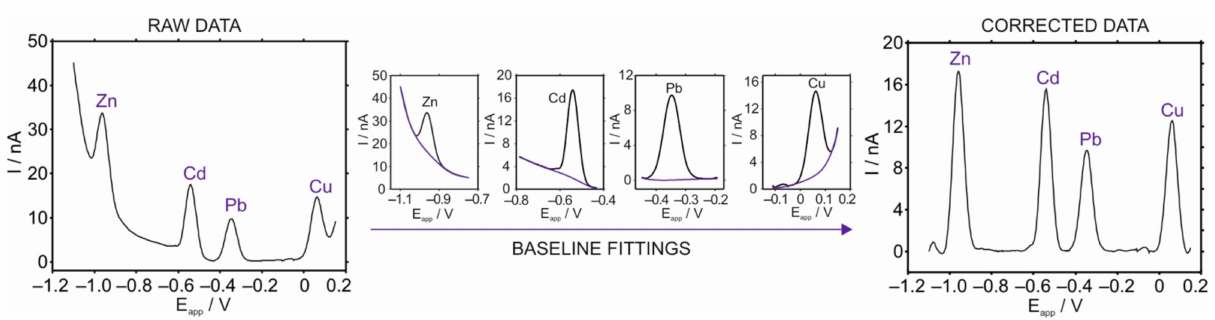
Figure 1. Illustration of the baseline correction for a real voltammogram showing multi-ion determination of Zn 2+ , Cd 2+ , Pb 2+ and Cu 2+